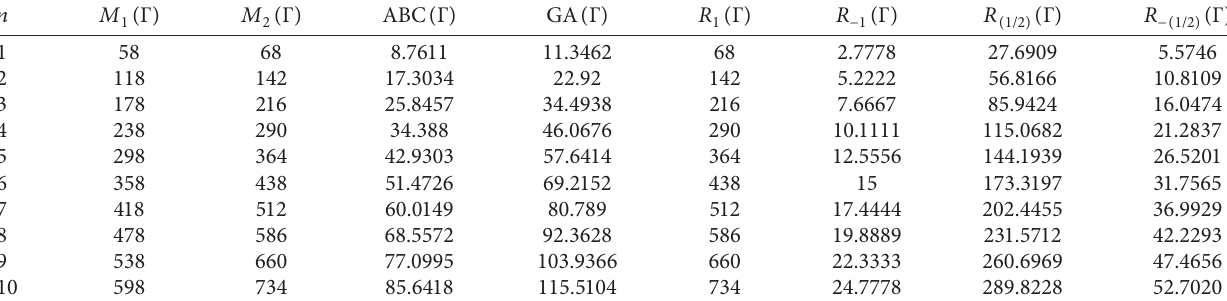
( Γ ) , M ( Γ ) , ABC ( Γ ) , GA ( Γ ) , R 1 2